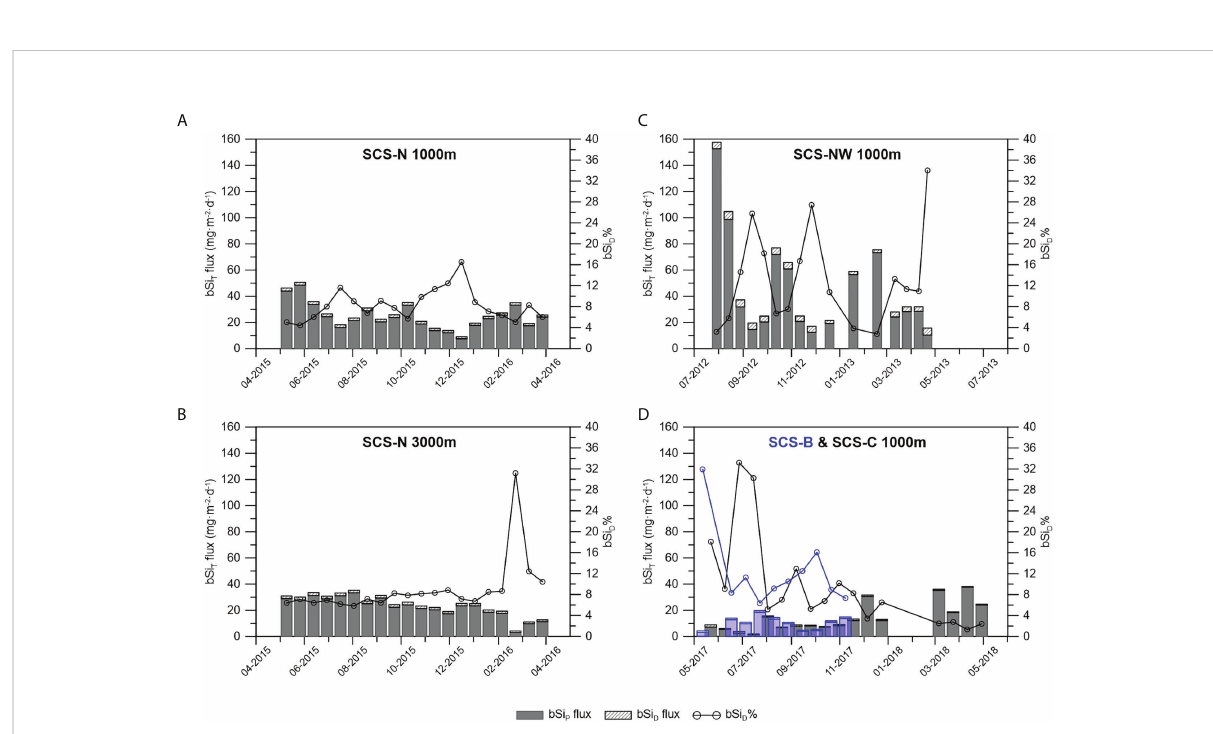
FIGURE 5 Revision of the bSi fl ux and contribution of bSi D to bSi T (bSi D %) at 1000m of station SCS-N (A) , 3000 m of station SCS-N (B) , 1000 m of station SCS-NW (C) and 1000m of station B & C with the blueish bars and blueish circles representing the data of SCS-B (D)